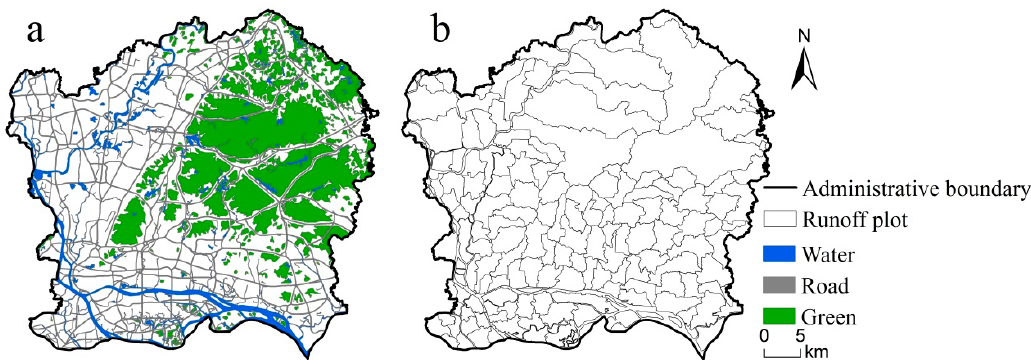
Figure 6. The prohibited optimization areas: ( a ) prohibited optimization areas; ( b ) urban runoff plots.